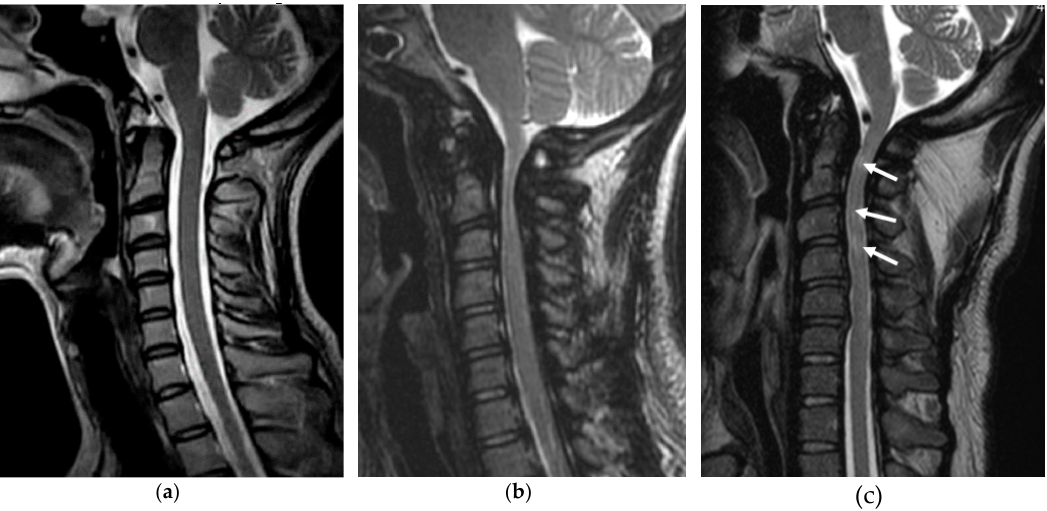
Figure 4. Cervical stenosis in MPS. Typical sagittal T2-weighed magnetic resonance image of the cervical spine in a normal adult ( a ), MPS I (31-year-old woman) ( b ), and MPS II (37-year-old man). GAG accumulation and stenosis is evident, especially around the odontoid process. Multiple T2